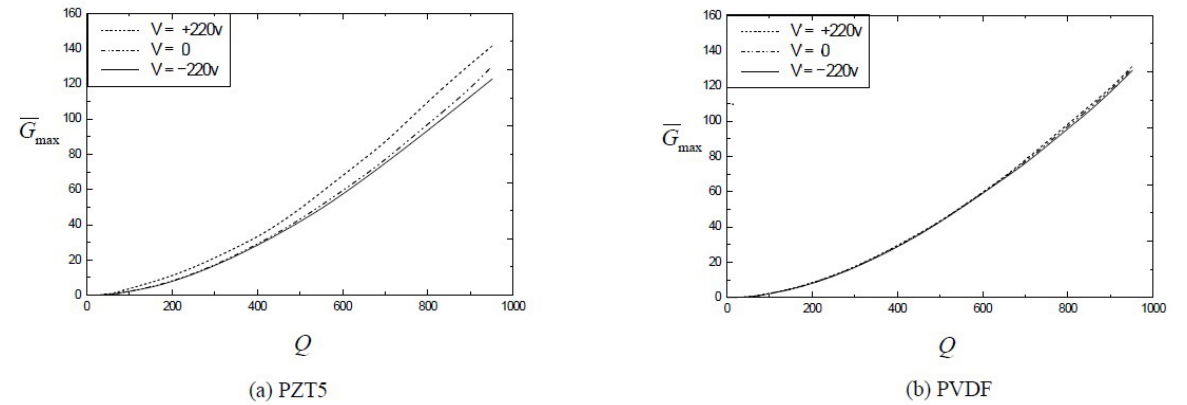
Fig. 6. Effect of voltage on ¯ G max of delaminated piezoelectric shell.